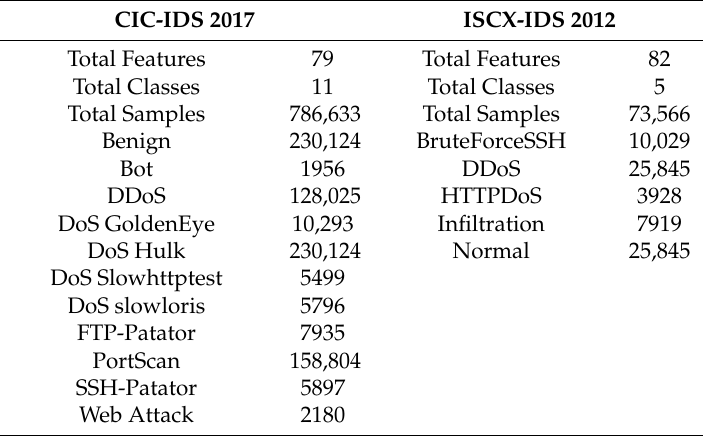
Table 2. Details of the CIC-IDS 2017 and ISCX-IDS 2012 datasets after pre-processing.